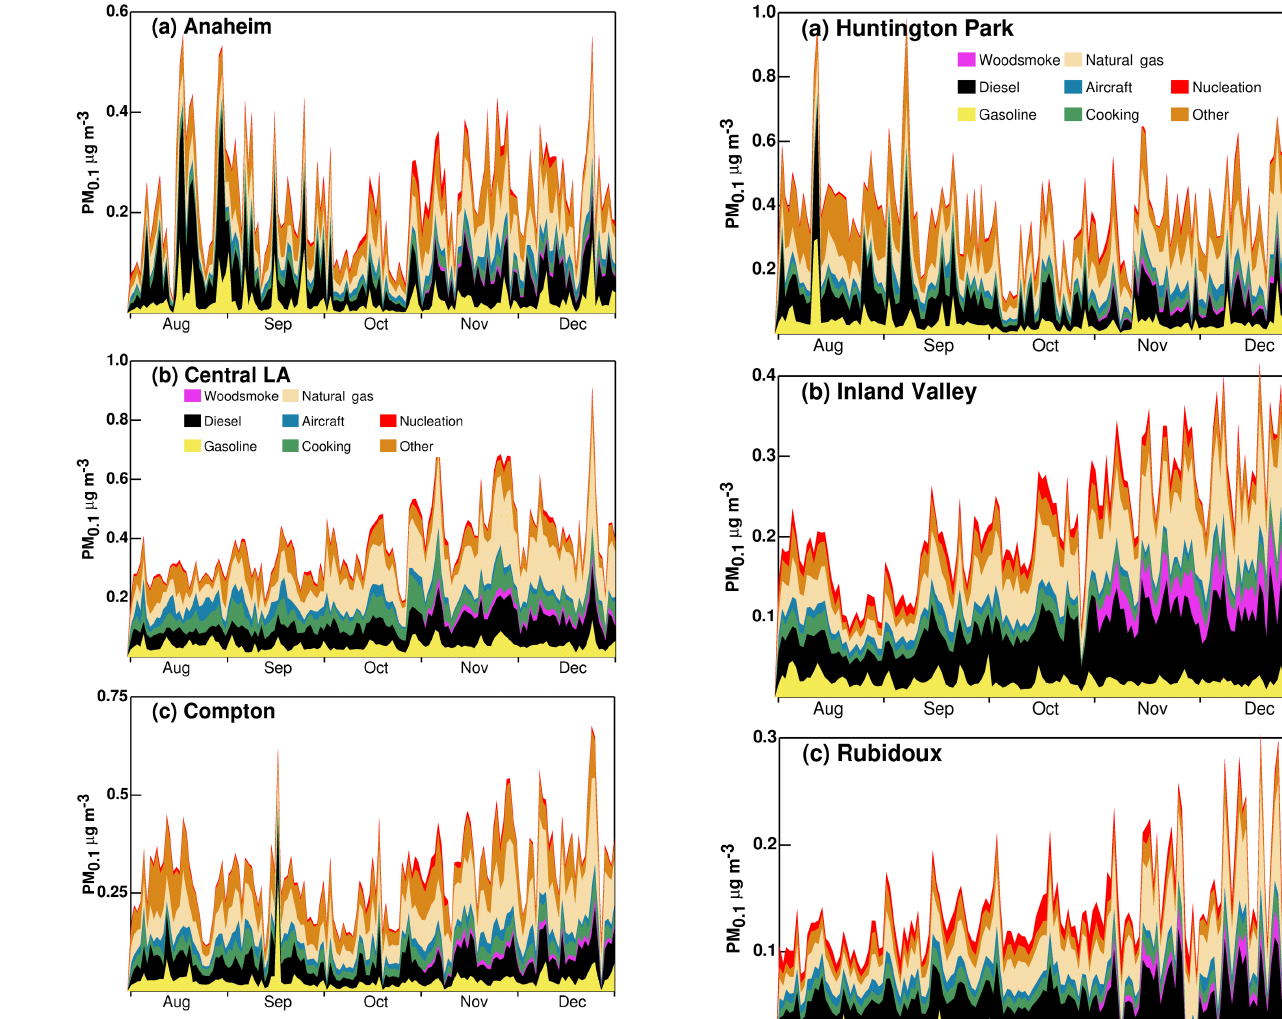
Figure 11. Seasonal variation of major source contributions to PM 0 . 1 at Anaheim, central LA, and Compton, respectively. Results within each month have daily time resolution.